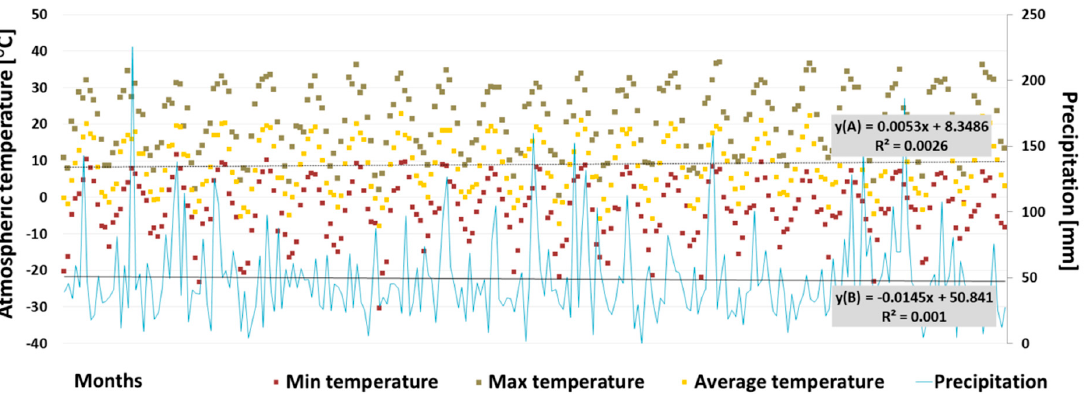
Figure 3. The range of monthly air temperature and monthly sum of precipitation over 20 years (January 1999–December 2019); y(A)—trend line of mean monthly air temperature; y(B) trend line of precipitation.